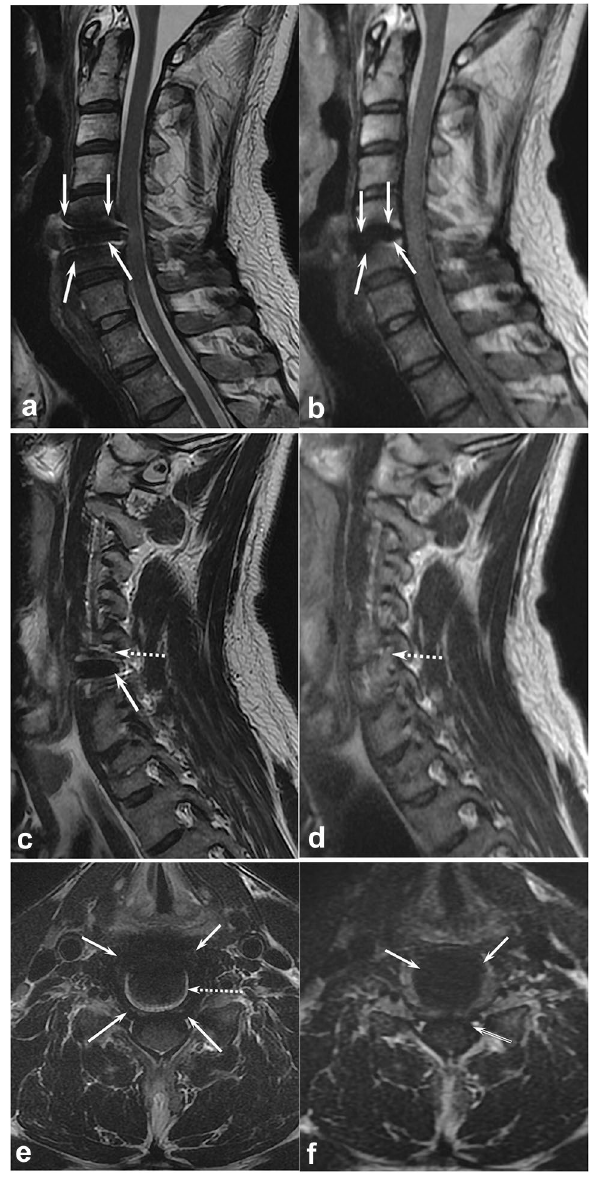
Figure 2. Comparisons of T2-weighted sequence (T2WI) ( a , c , e ) and multiacquisition with variable resonance image combination selective T2-weighted sequence (MAVRIC SL T2) ( b , d , f ) of the cervical spine of a volunteer (V3). ( a ) Mid-sagittal T2WI shows a metallic artifact (arrows) that obliterated anterior paravertebral soft tissue, upper and lower vertebral bodies, and anterior surface of the spinal cord. ( b ) Mid-sagittal MAVRIC SL T2 showed a markedly decreased signal void area (arrows) with nearly no geometric distortion and minimal signal pile-up. However, severe blurring was observed in the spinal cord. ( c ) Parasagittal T2WI at the left foramen level shows a signal void (arrow) obliterating more than half of the neutral foramen. Note the mild geometric distortion of the nerve root (dashed arrow). ( d ) Parasagittal MAVRIC SL T2 at the left foramen level visualized completely normal neutral foramen with no metallic artifact and no distortion of the nerve root (dashed arrow). ( e ) Axial T2WI at the operated level shows signal voids (arrows) obliterating the anterior subarachnoid space, anterior portion of the spinal cord, anterior paravertebral soft tissue, and both neutral foramina. Note the signal pile-up artifacts (dashed arrow). ( f ) Axial MAVRIC SL T2 showed a marked decrease in signal void (arrows) and almost no signal pile-up artifacts. However, the anterior subarachnoid space is obliterated by the low signal intensity of the cerebrospinal fluid pulsation artifact (double lined arrow). Severe blurring was noted in the spinal cord, with decreased T2